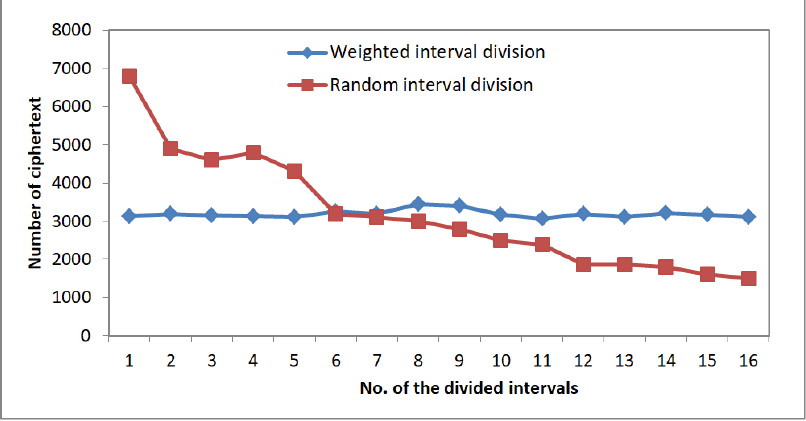
Figure 6. The distribution results of weight under different backgrounds.